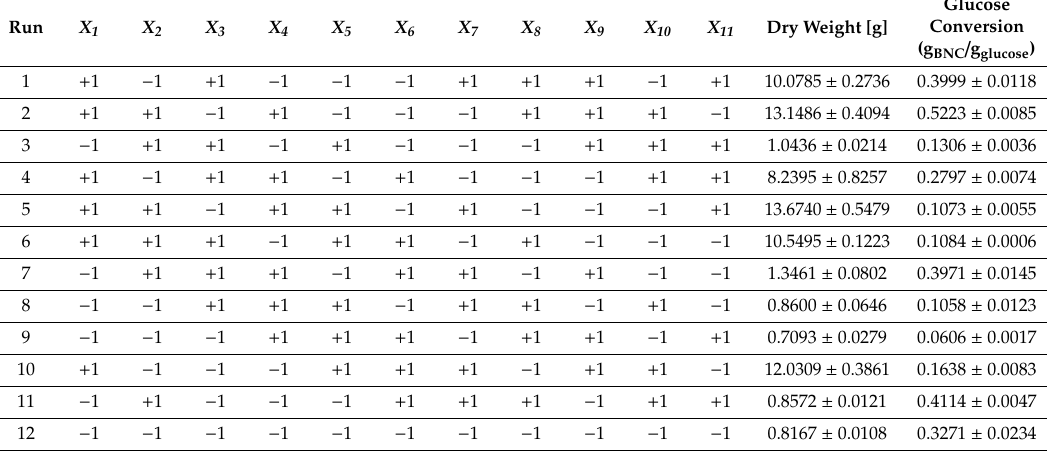
Table 2. Plackett–Burman design matrix and results. Symbols X correspond to factors, where X 1 is bioreactor area, X 2 -cultivation time, X 3 -age of inoculum, X 4 -s / v ratio, X 5 -glucose concentration, X 7 -air-flow ratio, X 9 -inoculum volume, X 10 -pH, and X 11 -humidity of